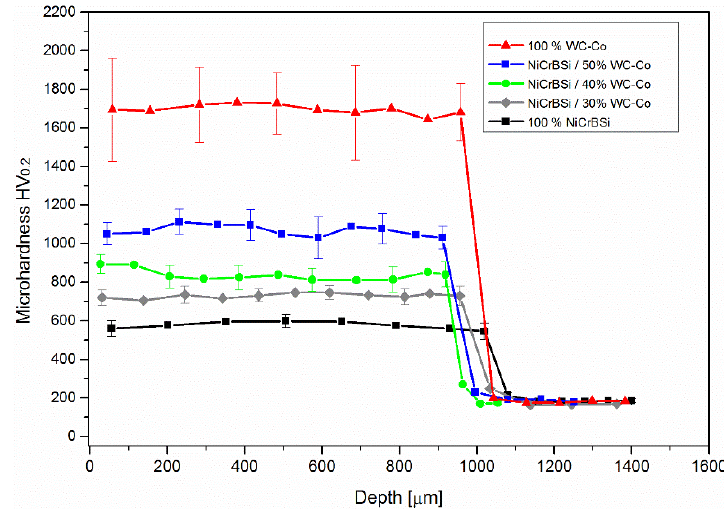
Figure 8. Through-depth microhardness.